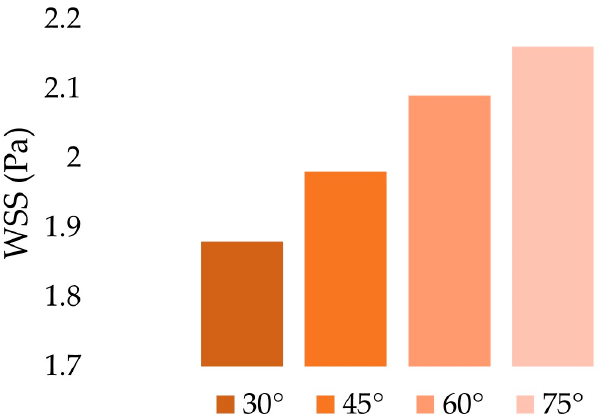
Figure 8. Spatial average of WSS over the whole host artery walls.